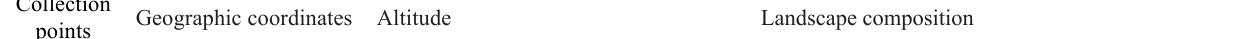
Table 1 . Collection points, geographic coordinates and landscape composition around collection points, totalling an area of 5 km radius. Collection